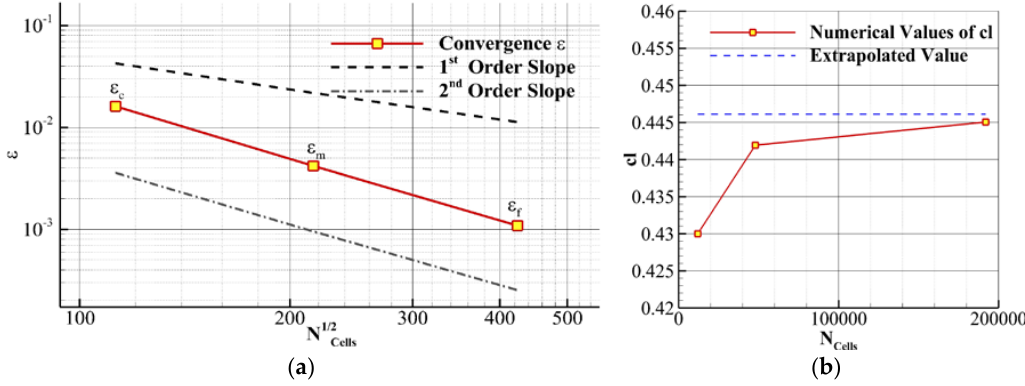
Figure 4. Assessing the mesh spatial convergence using ( a ) the Richardson’s extrapolation method; and ( b ) the logarithmic slope of the converged errors.